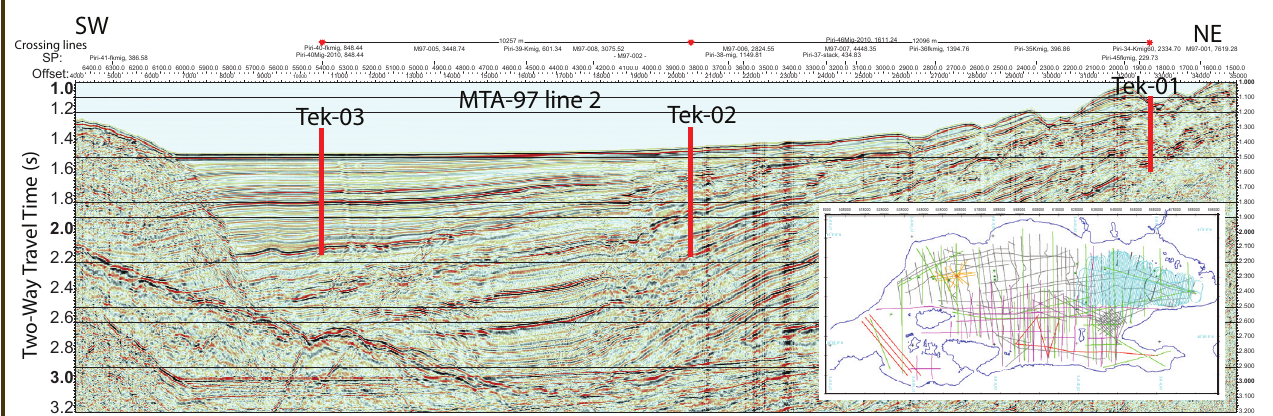
Figure 2. Multichannel seismic reflection (MCS) line MTA97 line 2 across Tekirdag Basin (white A–A ' line on Fig. 1; data from Parke et al., 2003). The red rectangles show the locations of potential drilling sites. Tek-03: this SW location was targeted to reach Pleistocene to Holocene strata deposited at high sedimentation rates at the deepest part of the basin (1200 m of water depth). Tek-02 (projected 2.7 km from the SE): targeted to reach Pliocene to Pleistocene strata. Tek-01 (projected 2.6 km from the SE): targeted at the condensed margin of the basin to reach Miocene to Holocene strata. Inset showing available high-resolution MCS data. Gray lines: TAMAM-2008 and PirMarmara Leg a4 (Sorlien et al., 2012). Orange lines are PirMarmara 2010 Leg a2 (P. Henry, G. Çifçi, and others, unpublished). Red lines are PirMarmara 2010 Legs a1, a3 (G. Çifçi and others, unpublished). The dense cyan grids are from Carton et al., 2007. Magneta are Marathon industry lines (C&K Petroleum, 1974). Green lines are from MTA97 (Parke et al.,